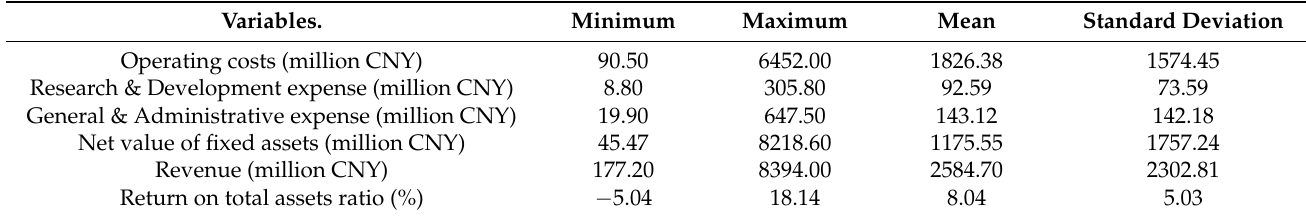
Table 4. Descriptive statistics of selected variables for 34 listed LED energy enterprises in 2017.